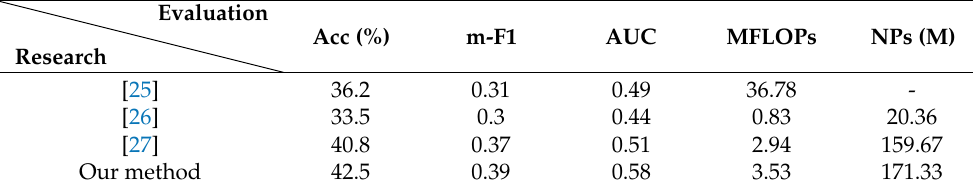
Table 6. Comparison with the other